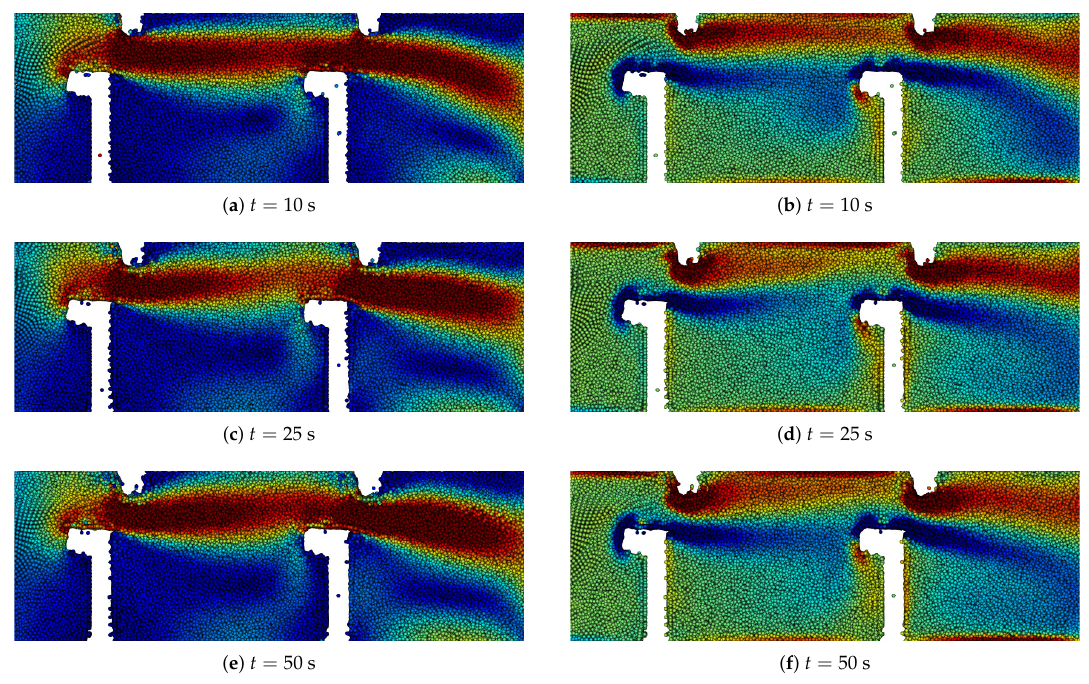
Figure 4. Contour maps of flow variables at z = − 0.5 m from the free surface (top view). Left panels represent velocity magnitude, colored from 0 m/s (blue) to 1.5 m/s (red). Right panels show contours of vorticity in z , from –3 rad/s (blue) to 3 rad/s